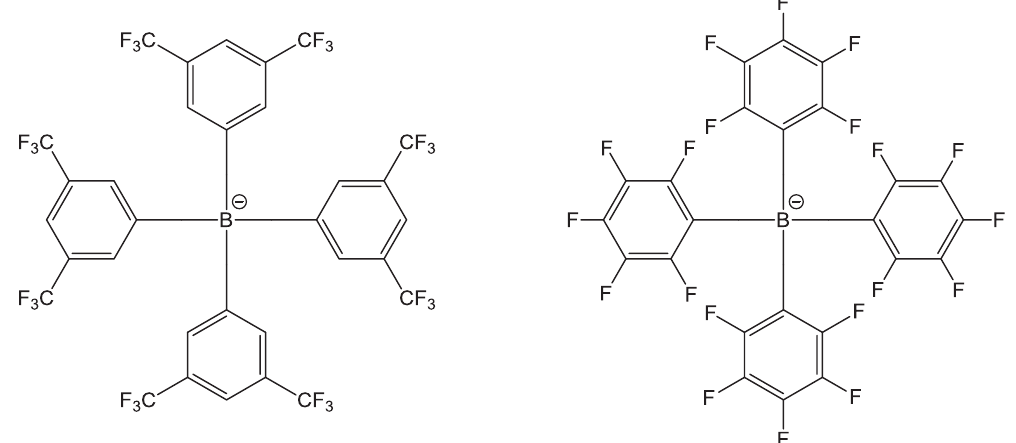
Table 1: Crystal data and structure refinement of [Li(1,2-F